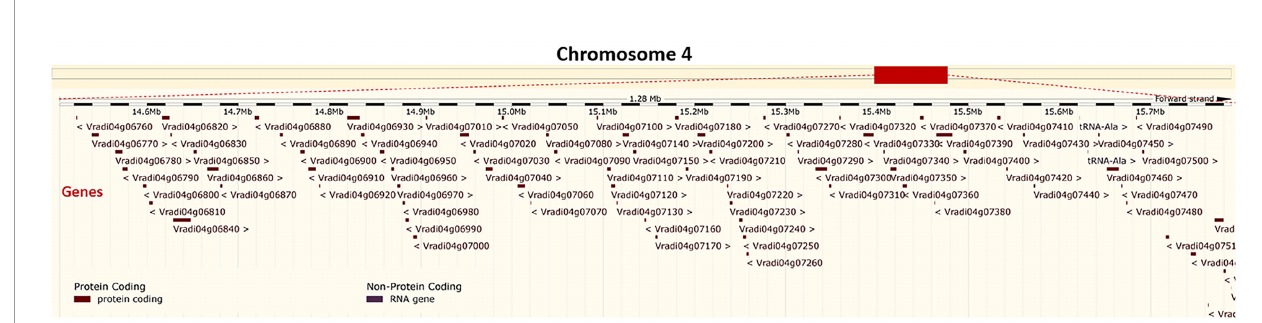
FIGURE 6 | Physical location of a major QTL (qMYMV4_1) on the mungbean chromosome 4: 14,504,302-15,788,321. This region possesses 18 candidate genes imparting YMD resistance (Derived from: Mathivathana et al.,